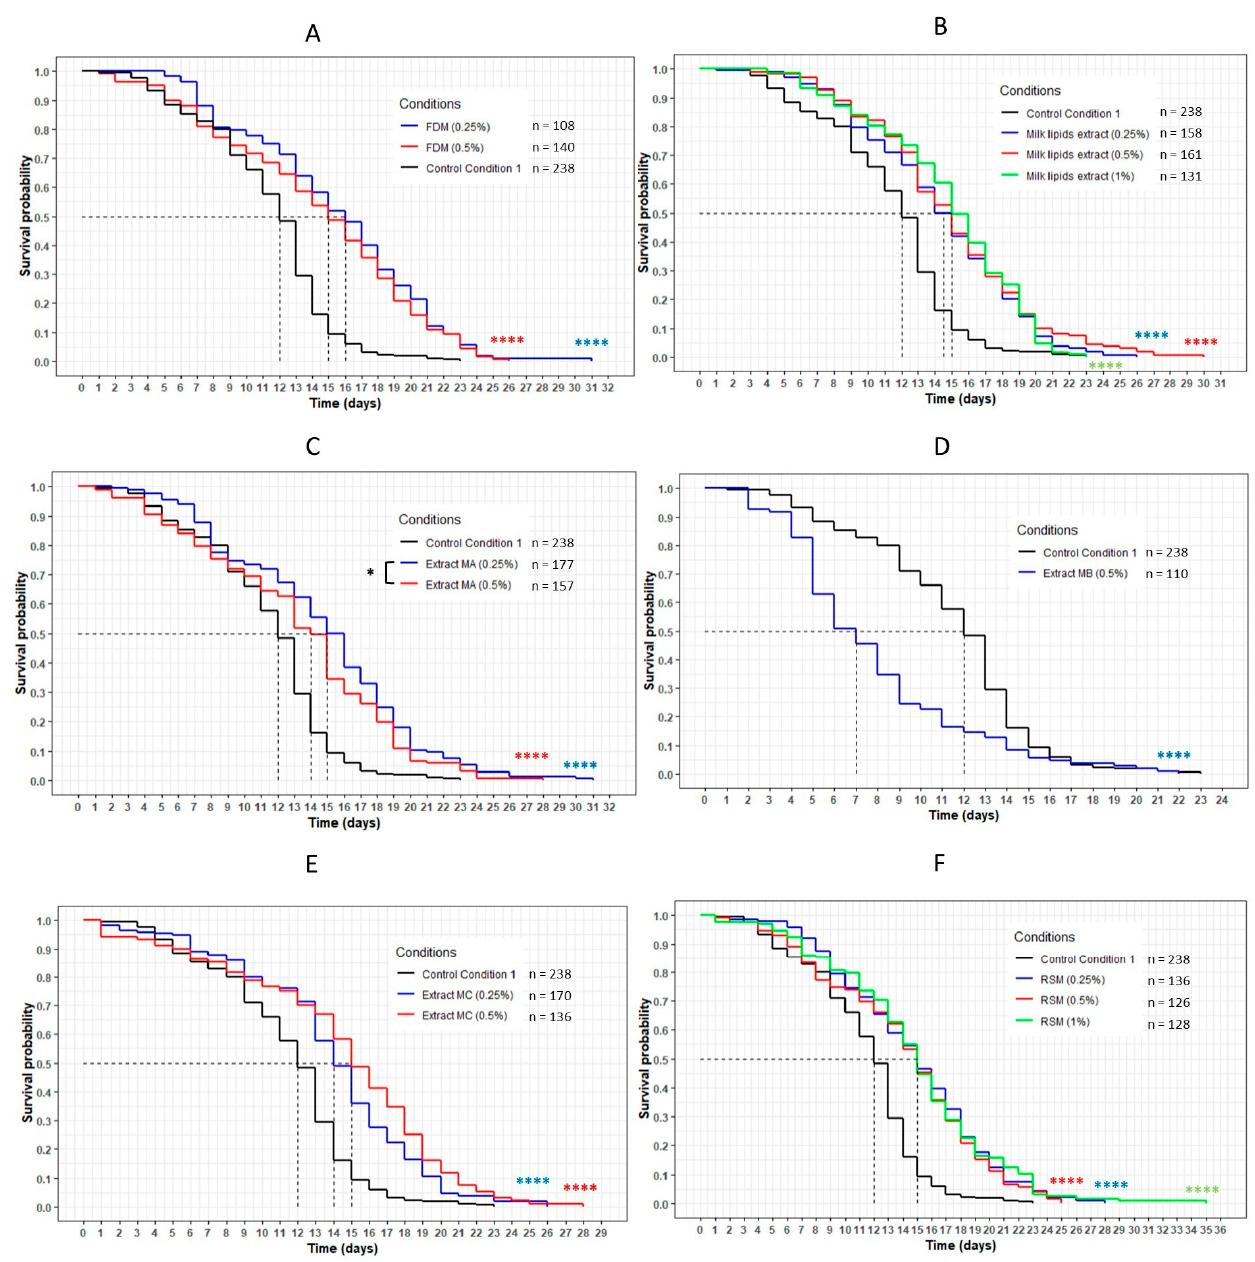
Figure 10. The influence of FDM (freeze-dried milk) ( A ), milk lipid extract ( B ), extracts MA (obtained with dichloromethane) ( C ), MB (obtained with ethyl acetate) ( D ), MC (obtained with ethanol) ( E ) and RSM (residual solid milk) ( F ) on the lifespan of wild-type C. elegans N2 strain. The worms were incubated on the medium supplemented with the dried extracts at day 0 and regularly fed with HK E. coli OP50. The conditions were considered significantly different when the p -value was lower than 0.05 (*) or 0.0001 (****). The asterisks next to the curves represent the differences with the control condition CC1. The asterisks next to the legend represent the differences between the extracts (log-rank test).